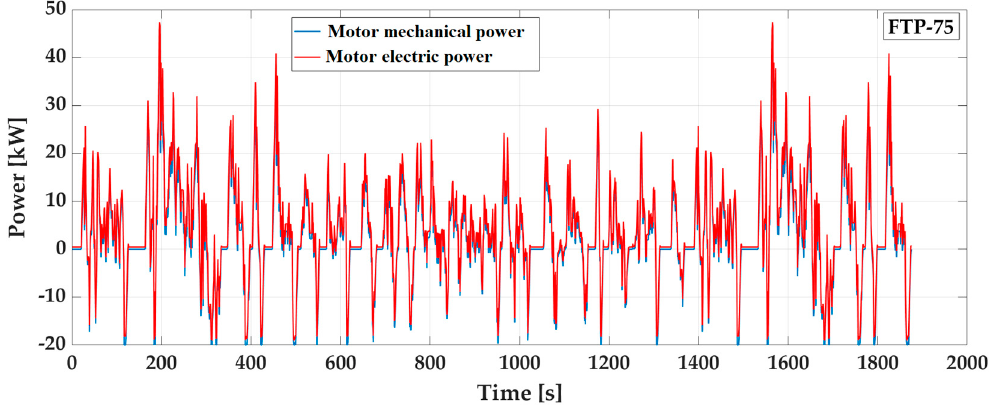
Figure 9. Motor electric and mechanical power vs. time for FTP-75 in the case of a single speed gearbox.